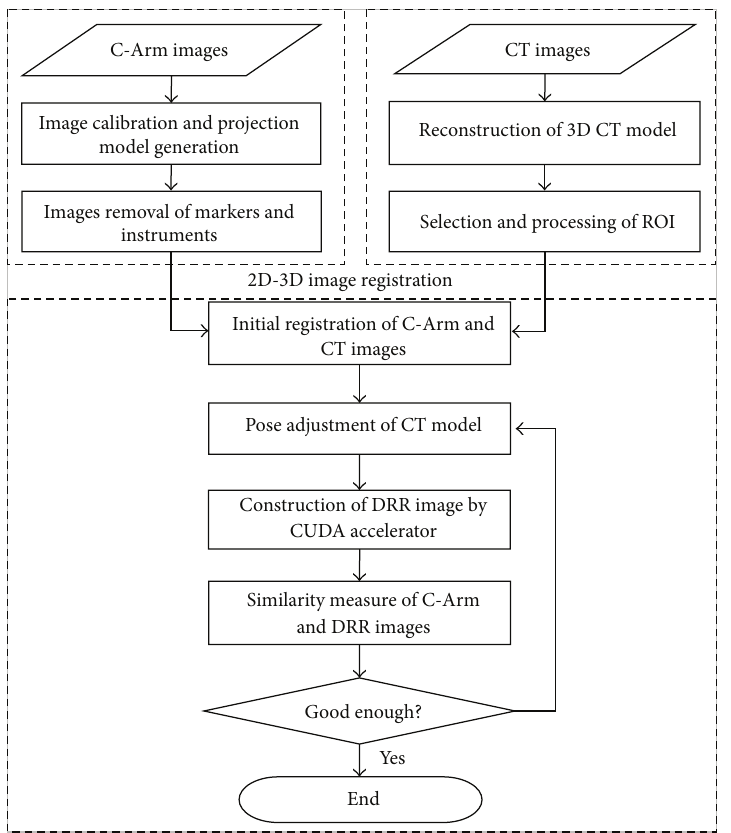
Figure 4: The procedure of 2D C-Arm and 3D CT images